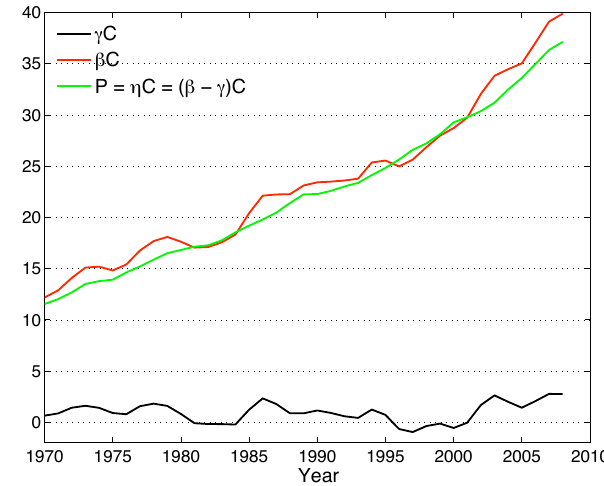
Fig. 3. As for Fig. 2 but for the product of the rate coefficients and total wealth C (Eq. 4). The difference between βC and ηC is the inflationary depreciation associated with each year γC (Eqs. 20 and 24).